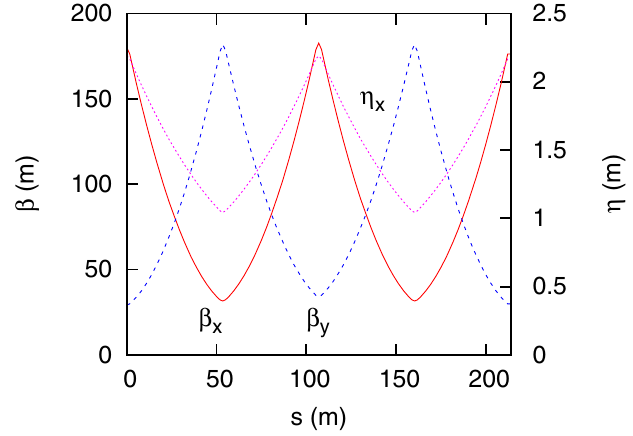
FIG. 19. (Color) Optics functions of the arc section (two cells) of LHC. The betatron phase advance is 180 degrees in both horizontal and vertical.